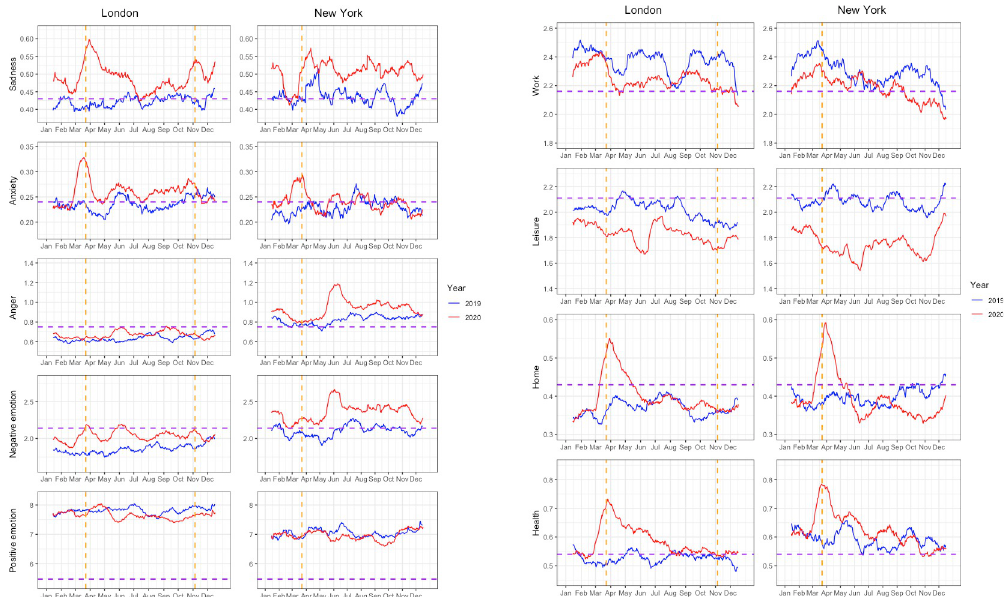
Fig 1. a Equally weighted 29-day moving averages of LIWC scores. Note . Orange dotted lines show the beginnings of the first (London and New York) and second (London only) lockdown; purple dotted lines show the Linguistic Inquiry and Word Count (LIWC) reference values for tweets; LIWC scores represent percentages of total in-category words. b Equally weighted 29-day moving averages of LIWC scores. Note. Orange dotted lines show the beginnings of the first (London and New York) and second (London only) lockdown; purple dotted lines show the Linguistic Inquiry and Word Count (LIWC) reference values for tweets; LIWC scores represent percentages of total in-category